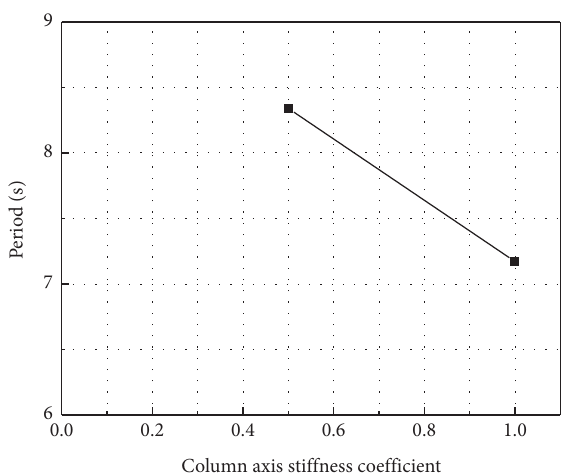
Figure 11: Influence of the column section bending stiffness co- efficient on the period.